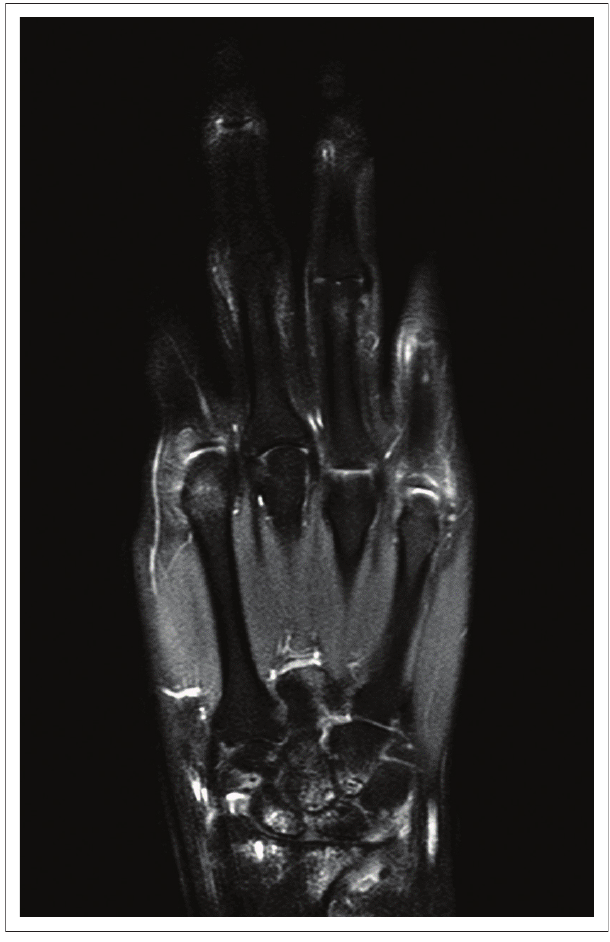
Note: This is the same patient in Figure 5, demonstrating multiple areas of high signal in the radius, ulnar and carpal bones in keeping with bone oedema. FIGURE 7: Proton density-weighted fat-saturated coronal magnetic resonance imaging.